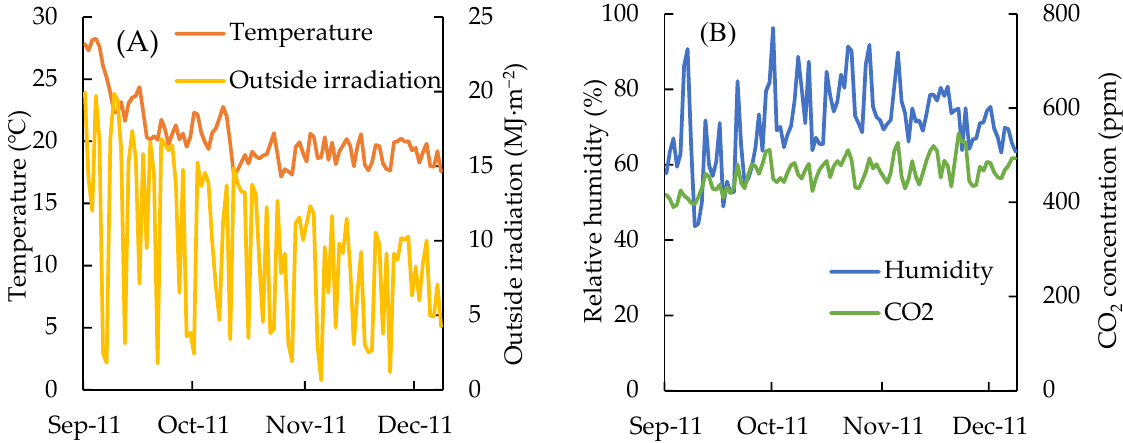
Figure 2. ( A ) indicates the change in daily mean temperature and outside irradiation, and ( B ) indicates the daily relative humidity and CO 2 concentration.